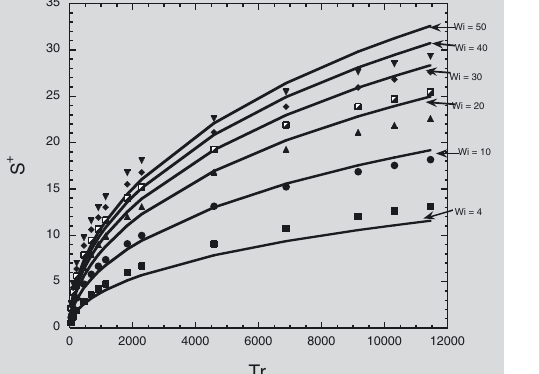
Figure 8 (left): Comparison of phenomeno- logical model (symbols) with Virk’s expression (lines) for the parallel upward shift, S + . Figure 9: Comparison of mean veloci- ty profile from the phenom- enological model (lines) with that from DNS (sym- bols)